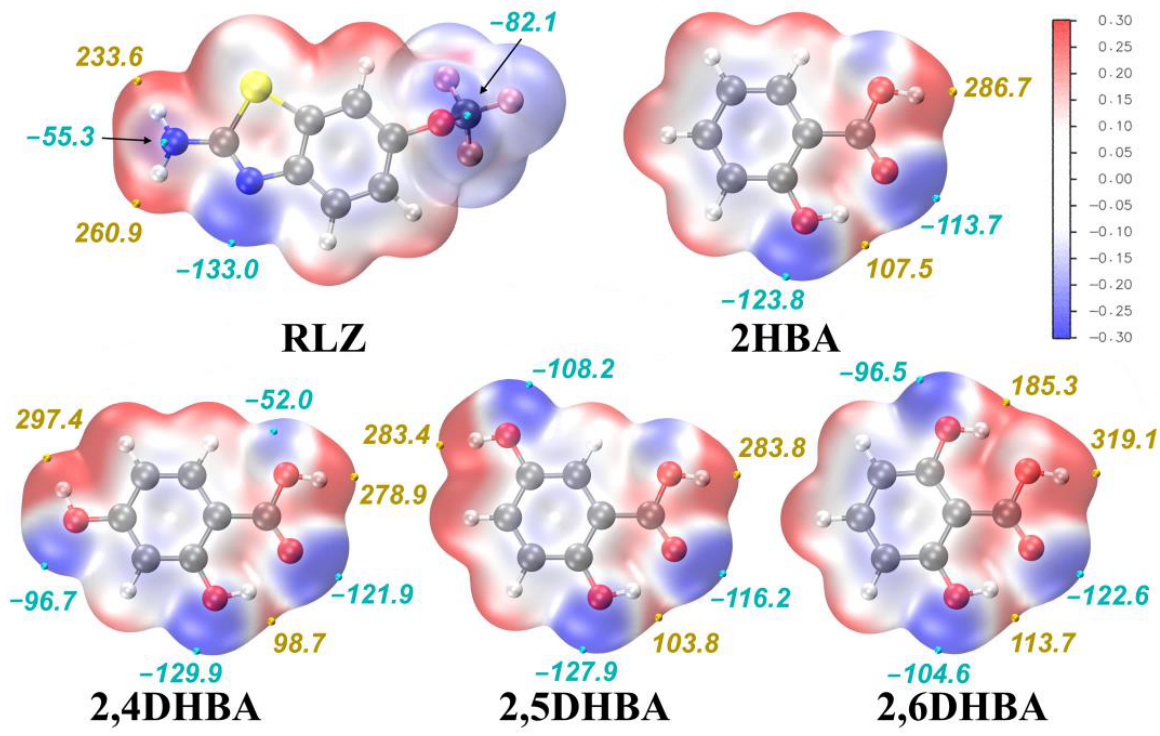
Figure 3. MEP mapped over total electron density, ρ = 0.002, isosurface for relaxed molecules of RLZ and the selected counterions. The isosurfaces are color-coded in the range between − 0.3 a.u. (blue) and +0.3 a.u. (red). The numbers display the selected electrostatic potential values of minima (cyan points) and maxima (yellow points) of selected electrostatic potentials values, in kJ mol −1 .